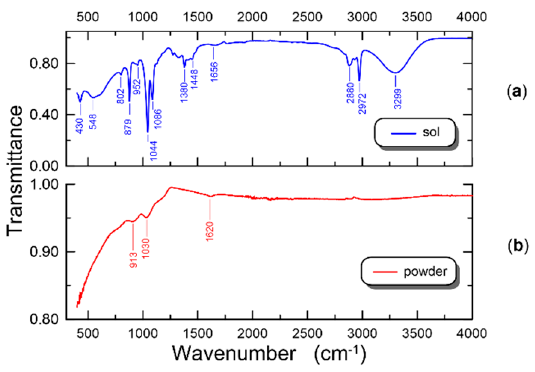
Figure 4. FTIR spectrum of the sol ( a ) and powder of silica-titania ( b ). In the FTIR spectrum of the SiO x :TiO y powder (Figure 4b) there are no absorption bands resulting from the vibrations of hydroxyl groups (3299 cm − 1 , 1380 cm − 1 ).